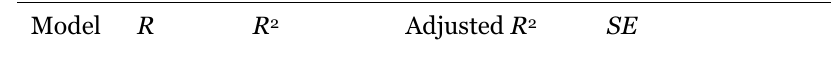
Summary shows the success of the research model